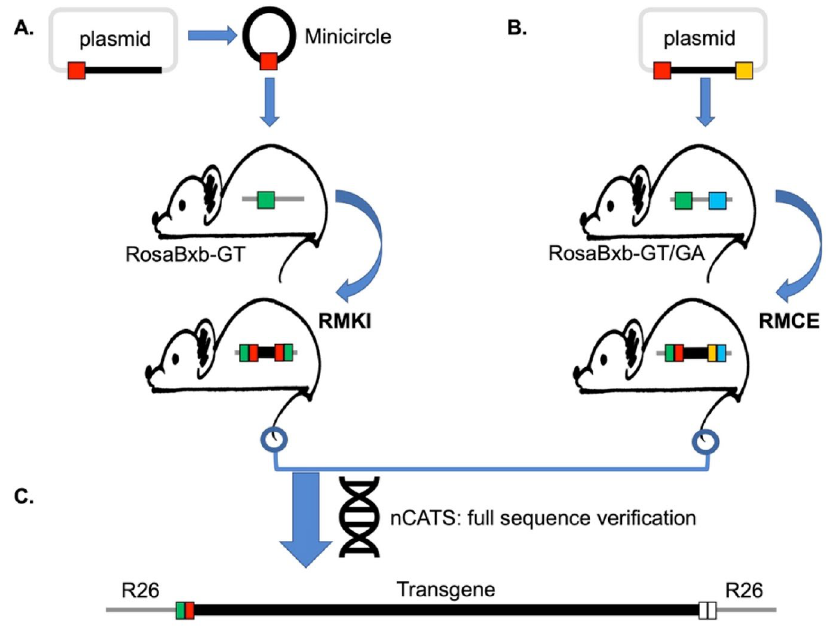
Figure 1. Overview of the Bxb1 Int-mediated transgenesis strategy. ( A ) Schematic showing RMKI allele generated by in vivo recombination between vector free minicircle donor DNA carrying a single attB site and host mouse containing a single cognate attP site in the ROSA26 locus (RosaBxb-GT). ( B ) Recombinase- Mediated Cassette Exchange (RMCE) allele generated by in vivo recombination between plasmid DNA, carrying two flanking heterologous attB sites and host mouse carrying dual cognate attP sites (RosaBxb-GT/GA) in the ROSA26 locus. ( C ) Nanopore Cas9-targeted sequencing (nCATS) enables complete verification at the sequence level of the entire transgene including the adjacent genomic DNA